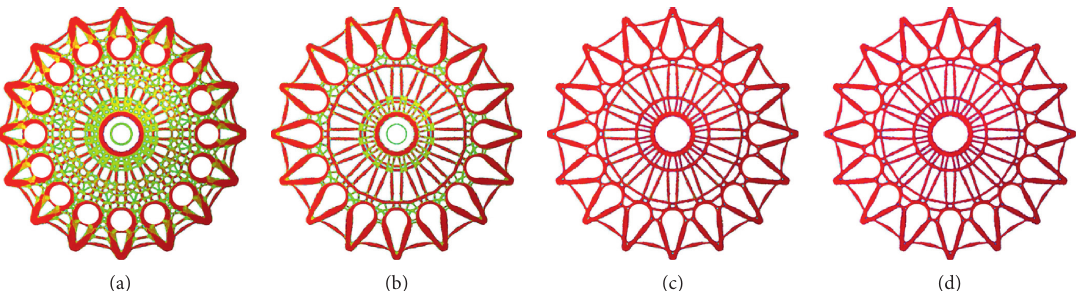
Figure 6: Optimization results of a spherical shell with predefined holes (project view). (a) 40 th iteration. (b) 60 th iteration. (c) 80 th iteration. (d) 95 th iteration.